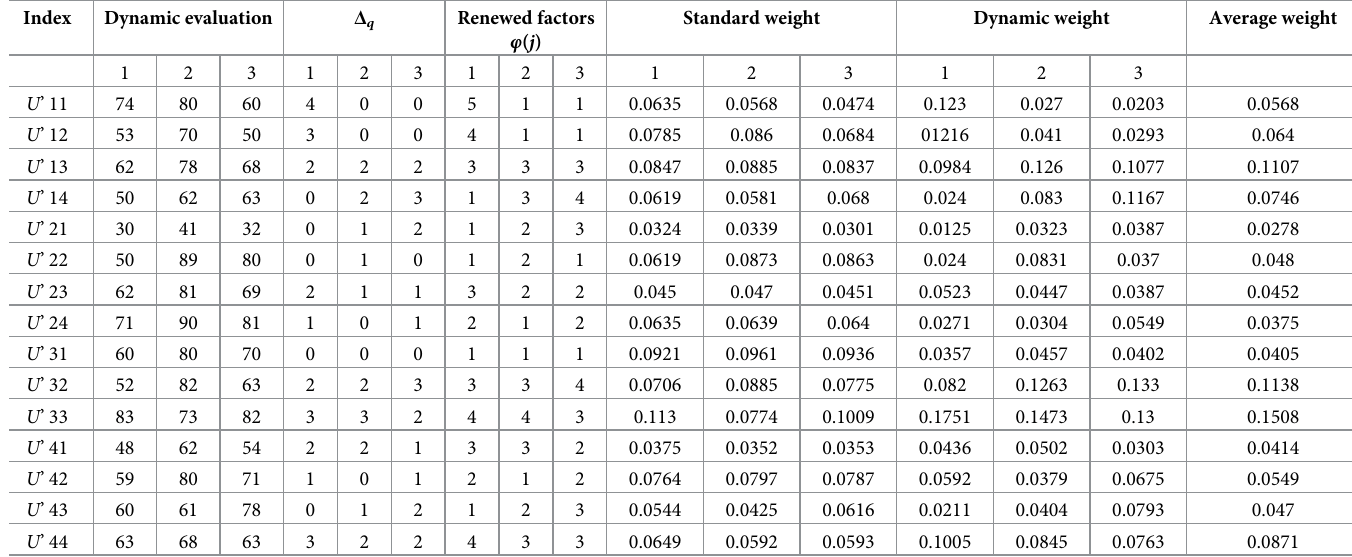
Table 5. Update indicators and dynamic weights of each